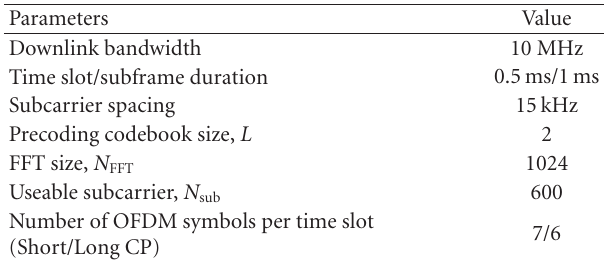
Table 4: OFDMA parameters.